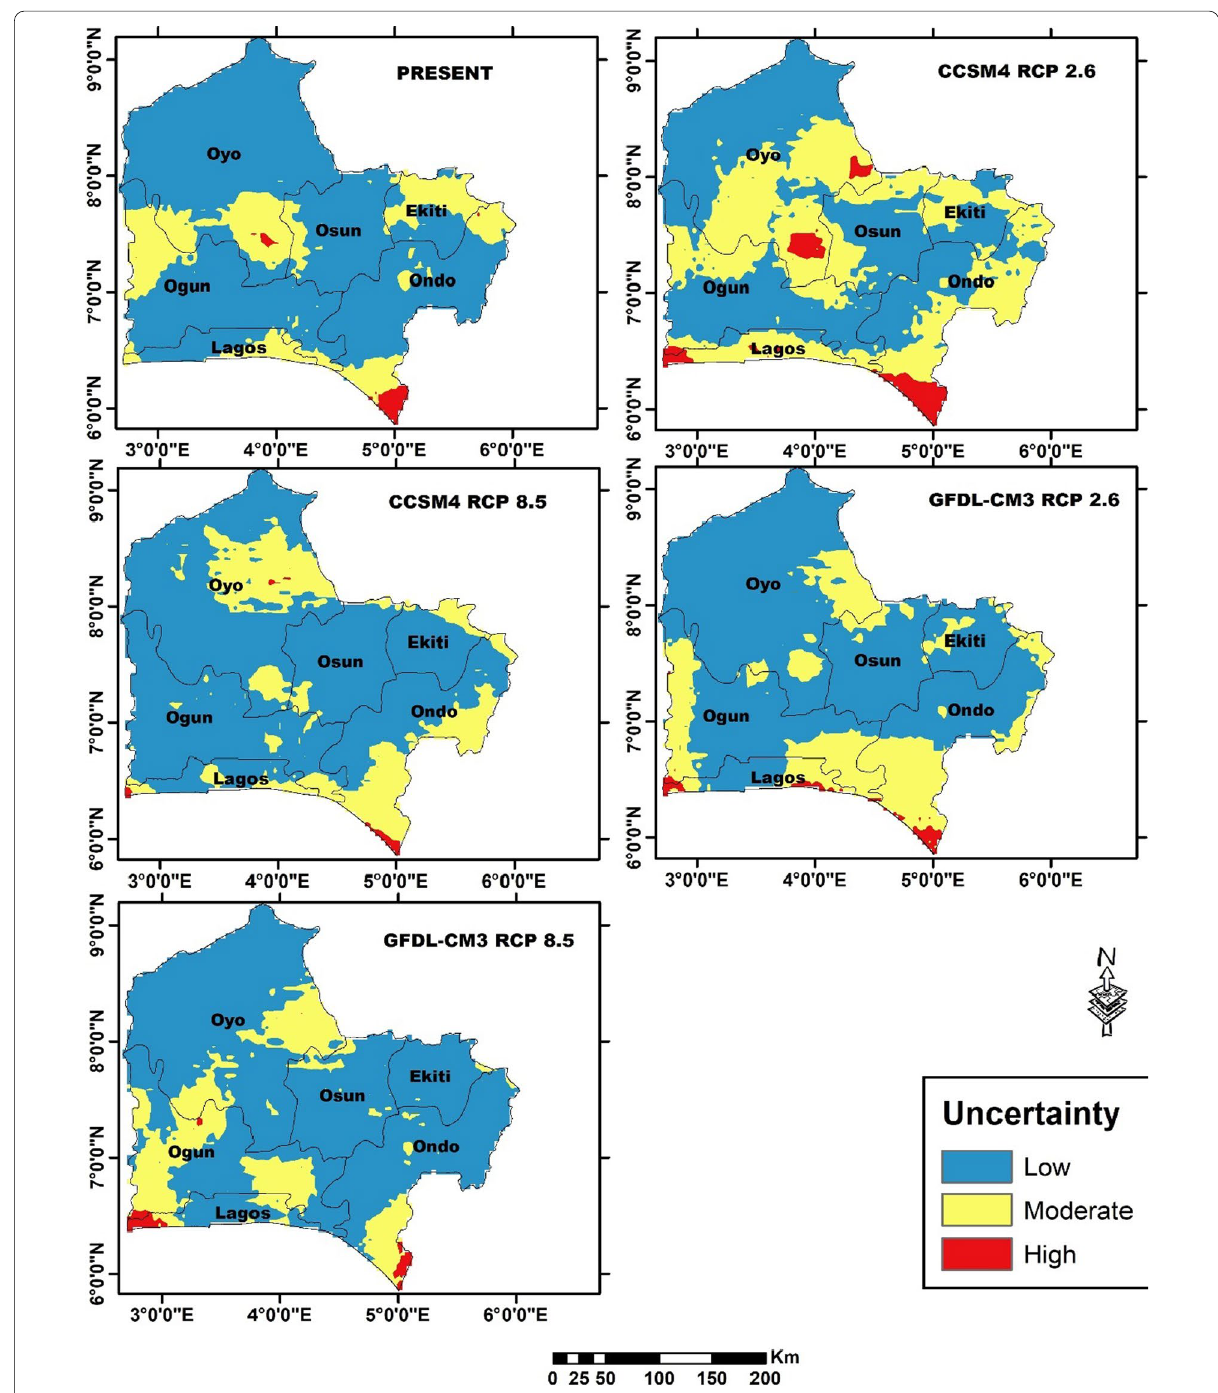
Fig. 4 Model uncertainty of present-day and future climatic suitability for An.